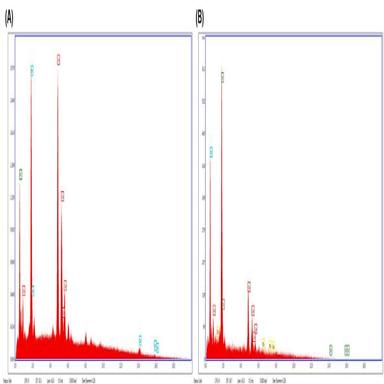
EDS spectrum of (A) host and (B) SCD7 NPs.